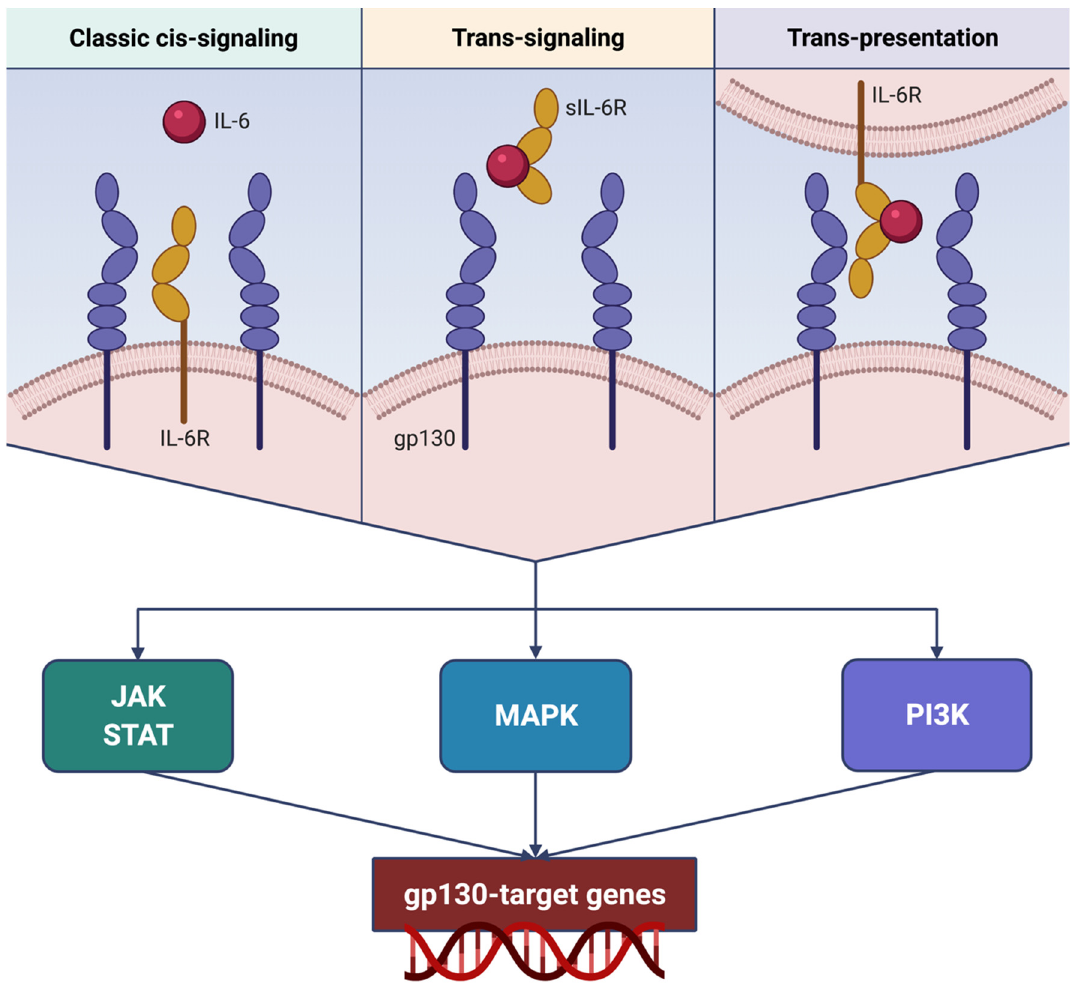
Figure 3. Different mechanisms underlying IL-6R activation and signaling. IL-6 can either interact with membrane-bound IL-6R (classic cis-signaling), or bind to sIL-6R (trans-signaling), or even be trans-presented from dendritic cells through their surface IL-6R to T lymphocytes (trans-presentation). Classic cis-signaling, trans-signaling, and trans-presentation converge on downstream transduction pathways, consisting of dimeric gp130-dependent activation of complex networks including JAK/STAT, MAPK, and PI3K signaling modules. Via these intracellular enzyme systems, IL-6R-triggered biological signals reach the nucleus and stimulate gp130 target genes involved in cell growth and proliferation. This original figure was created by the authors using BioRender.com. IL-6: interleukin-6; IL-6R: interleukin-6 receptor; sIL-6R: soluble interleukin-6 receptor; gp130: glycoprotein 130; JAK: Janus kinases; STAT: signal transducers and activators of transcription; MAPK: mitogen-activated protein kinases; PI3K: phosphoinositide 3-kinase.